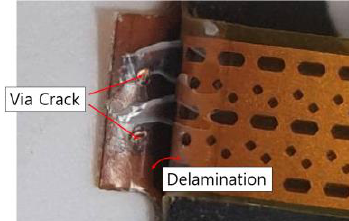
Figure 2. Image of a via crack due to delamination between CCLs caused by low flexibility. Second, bonding materials should be excluded when stacking CCLs in the structure.